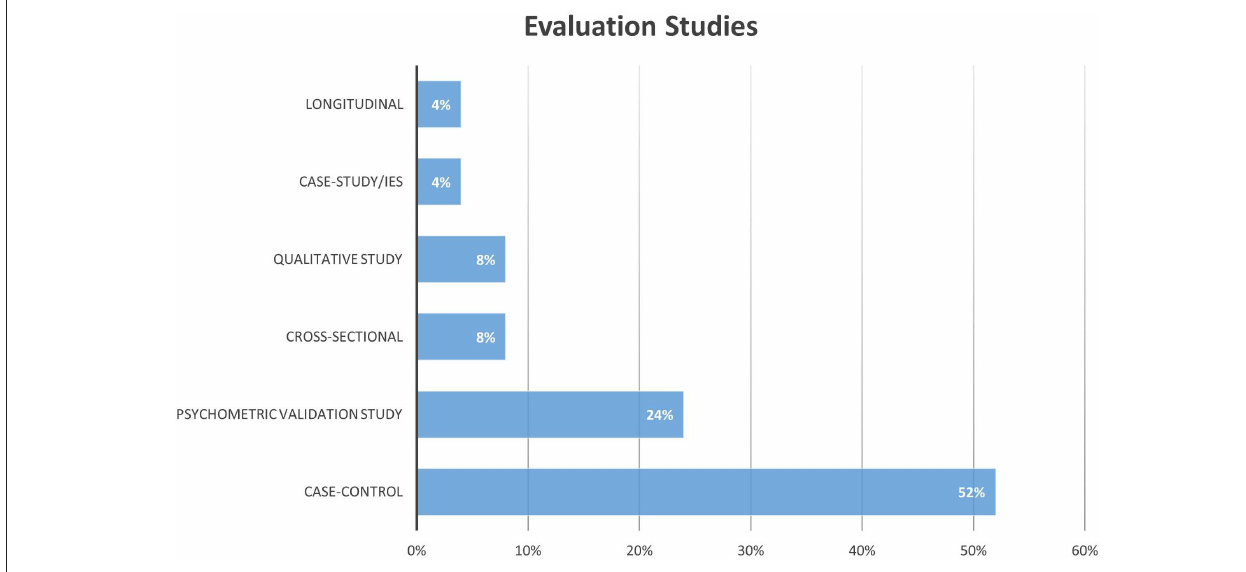
FIGURE 5 | Summary of the distribution of evaluation studies for research design adopted.